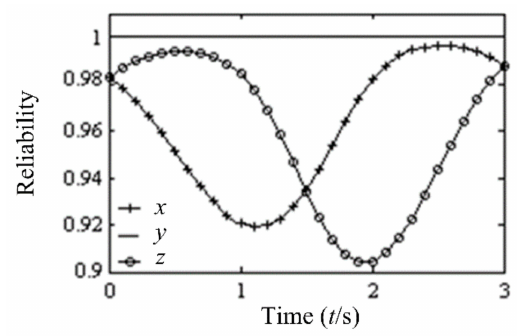
Figure 5. Calculation results of kinematic reliability.